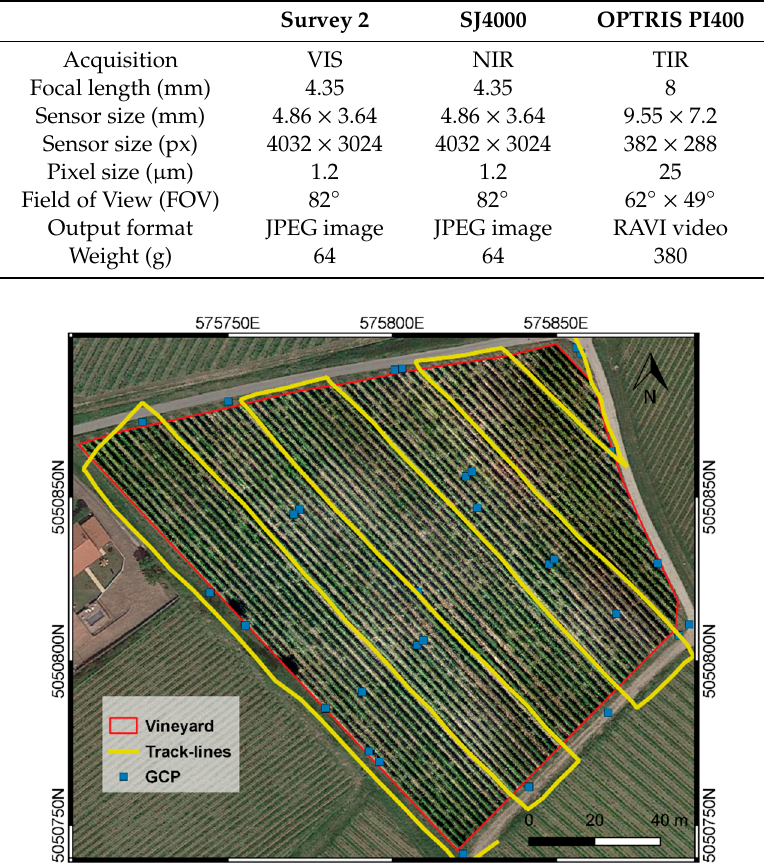
Figure 3. Flight track-lines for multispectral images acquisition and Ground Control Points (GCPs) distribution. Map data: © Google Satellite.